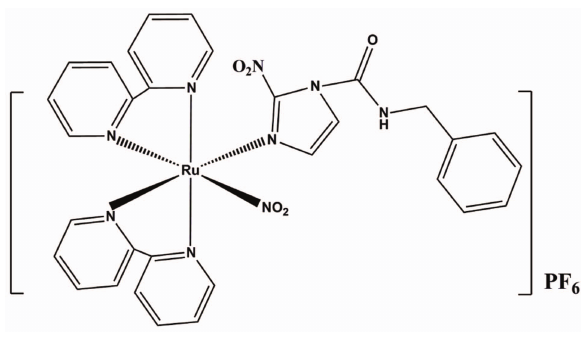
Figure 1. Chemical structure of RuBzNO 2 .